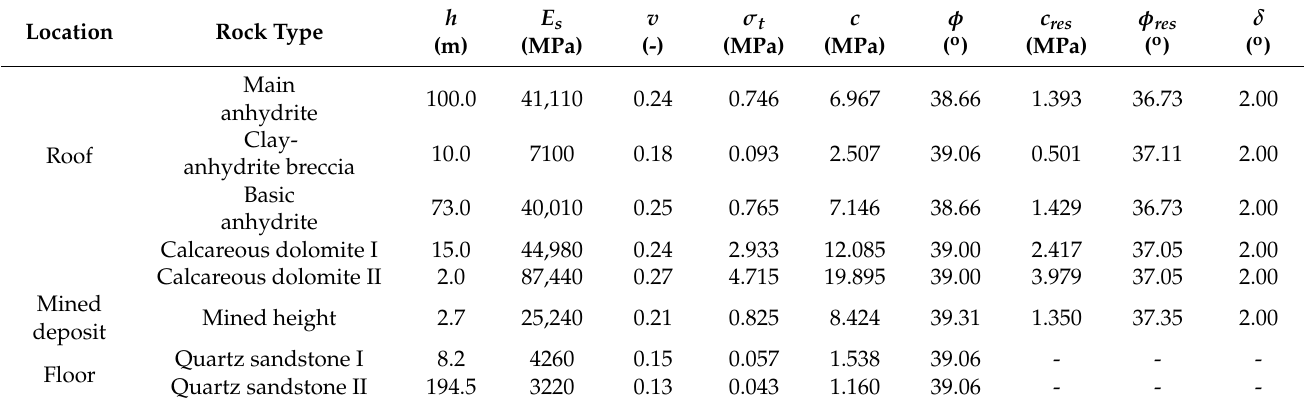
Table 1. Rock mass parameters used in the numerical model of the analyzed region [11].